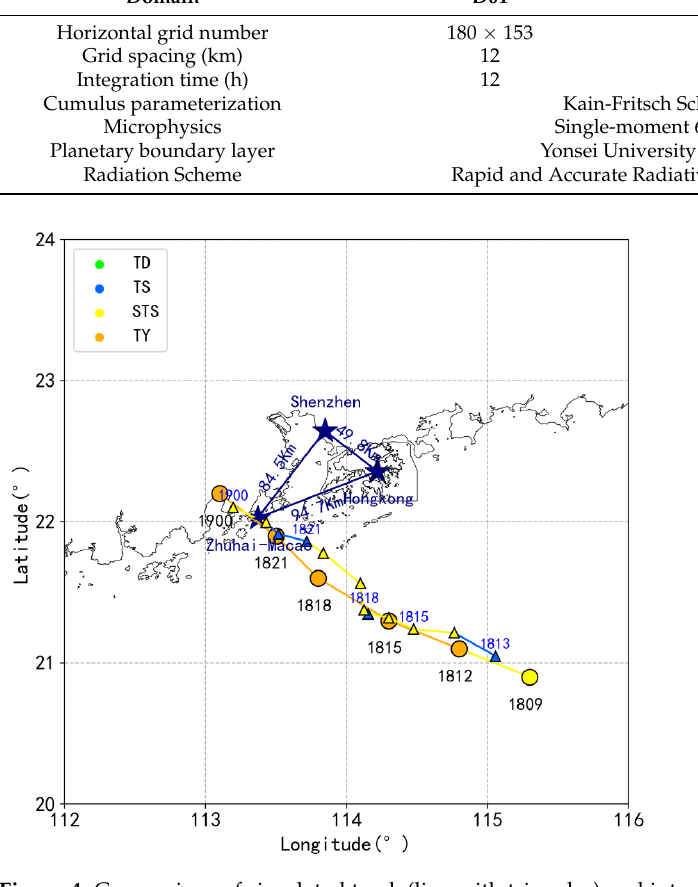
Figure 4. Comparison of simulated track (line with triangles) and intensity (colored) with best track (line with circled dots) and intensity (colored) of Typhoon Higos. Table 2. Model configuration for the control experiment.